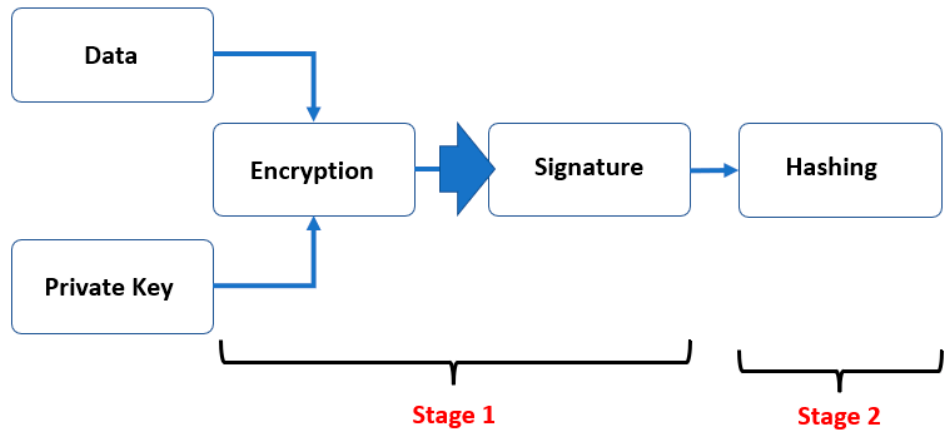
Figure 8. The encryption algorithm (Stage 1) and hashing algorithm (Stage 2).